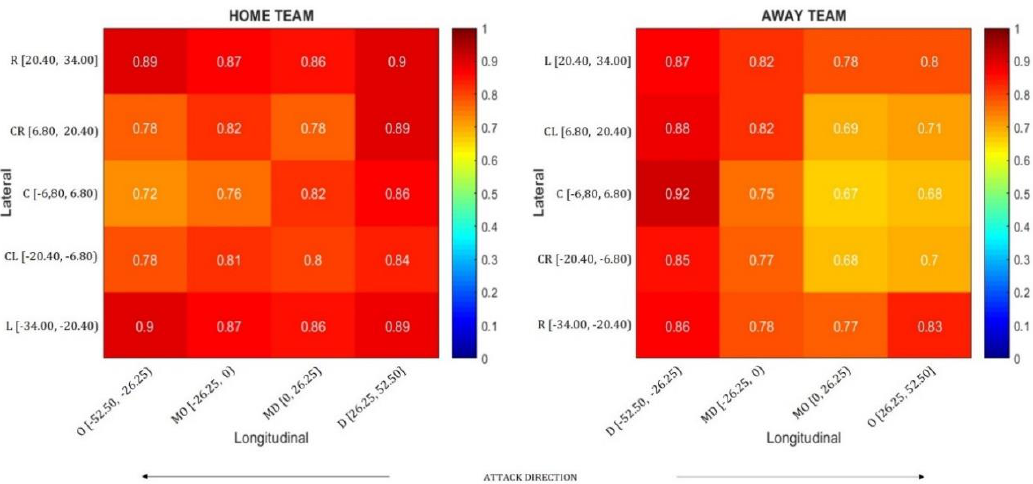
Figure 3. The impact of each zone in mean synchronization ( 𝑟́ ) values, for the without ball role. The lateral and longitudinal coordinates are represented, in meters, next to each zone code: O—offensive; MO—mid-offensive; MD—mid-defensive; D—defensive; R—right; CR—center-right; CL—center-left; L—left. The red-blue gradient scale indicates the synchronization values range from 0 to 1. Ball position data were inverted on the second half to make the results uniform for one unique direction per team.